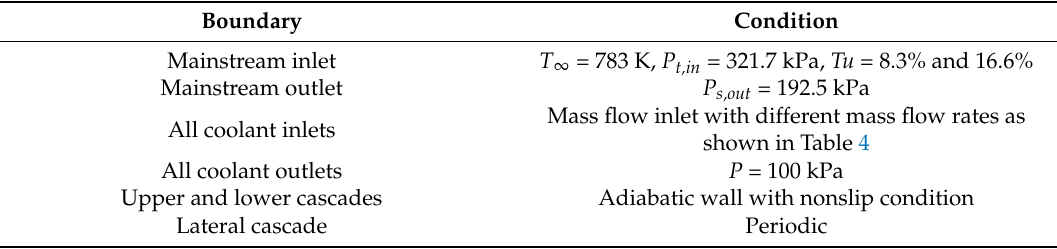
Table 3. Boundary conditions of the external